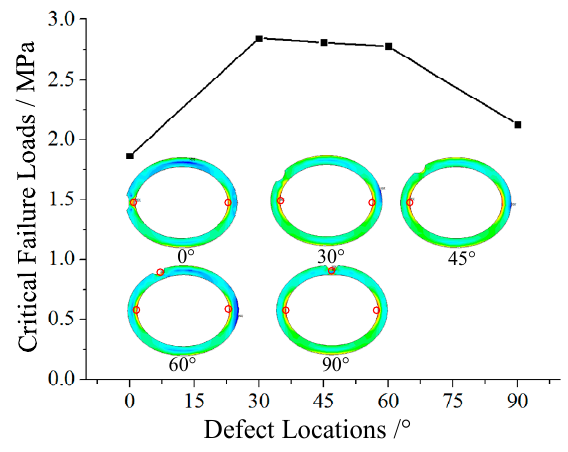
Figure 12. Critical failure load of the HDPE pipeline with various defect locations.